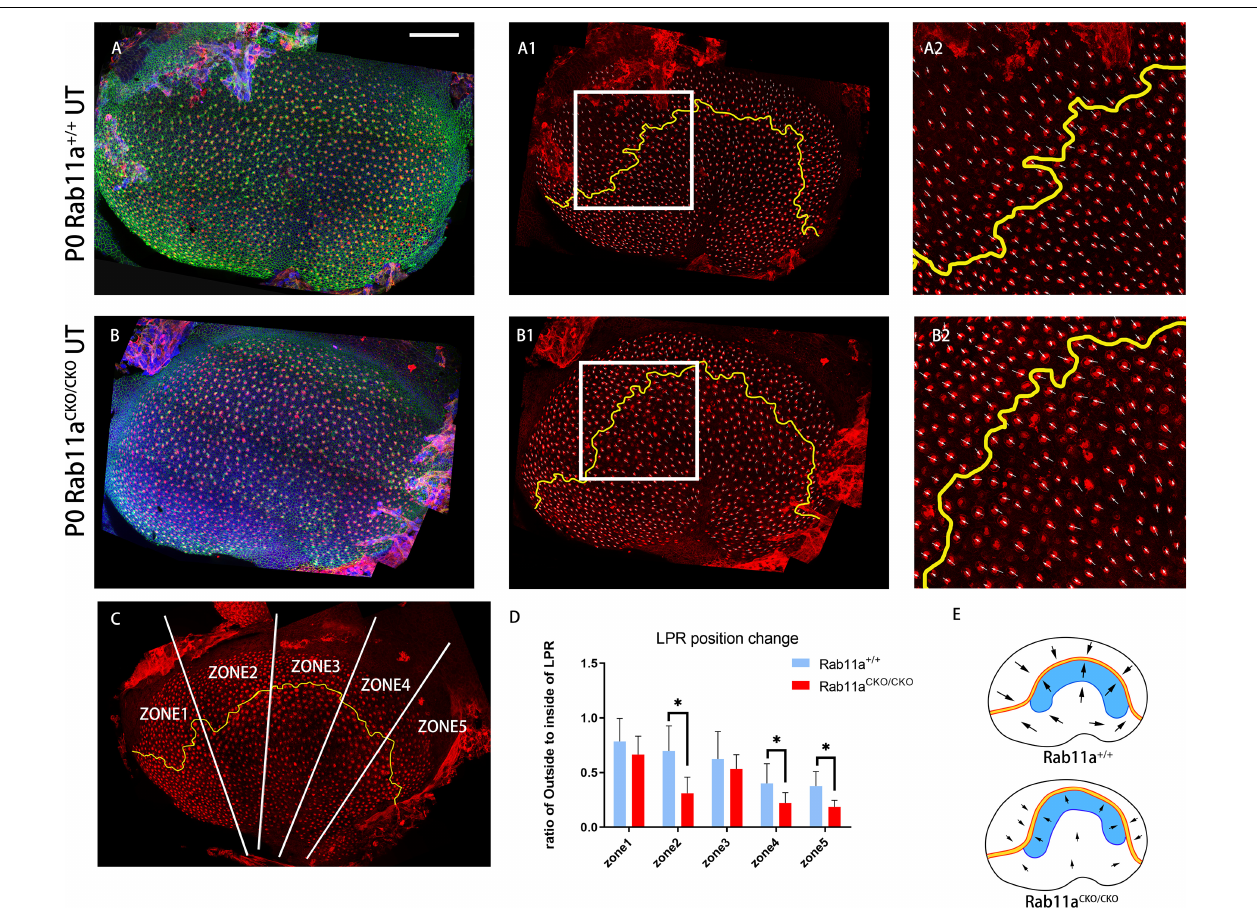
FIGURE 3 | Changes in shape and position of the line of polarity reversal (LPR) in Rab11a CKO / CKO utricles. (A–A2) In utricular macules of wild-type controls, the planar cell polarity of hair cells was labeled with the cell intrinsic planar cell polarity protein β -spectrin (red). White arrowhead shows the orientation of hair cells. Utricular hair cells were oriented with their bundles pointed toward each other along the LPR (yellow line). (A2) Zoomed image of white square in (A1) . (B–B2) In the Rab11a mutant utricle, the utricle was flattened compared to the wild-type utricle. (B2) Zoomed image of white square in (B1) . (C) The utricle was separated into five segments (white line) of similar size according to the length of the LPR (yellow line). The numbers of hair cells located inside and outside the LPR were counted. (D) The ratio of the number of hair cells located outside to inside of the LPR was calculated in each of the five segments for each genotype. Five mice were assayed at P0 for each of the wild-type and Rab11a knockout groups. Statistical analyses were performed using Student’s t -test with unequal variance, ∗ P < 0.01. The lower ratios in regions 2, 4, and 5 of the Rab11a CKO / CKO group indicated that there were fewer hair cells located outside the LPR compared to the wild-type controls, while the total number of hair cells in the utricle was not significantly different between the two groups, and we concluded that the LPR moved toward the outside. (E) Schematic view of control and Rab11a CKO / CKO utricle the LPR moved toward the outside in mutant utricle (black arrow). Scale bars: 100 µ m.